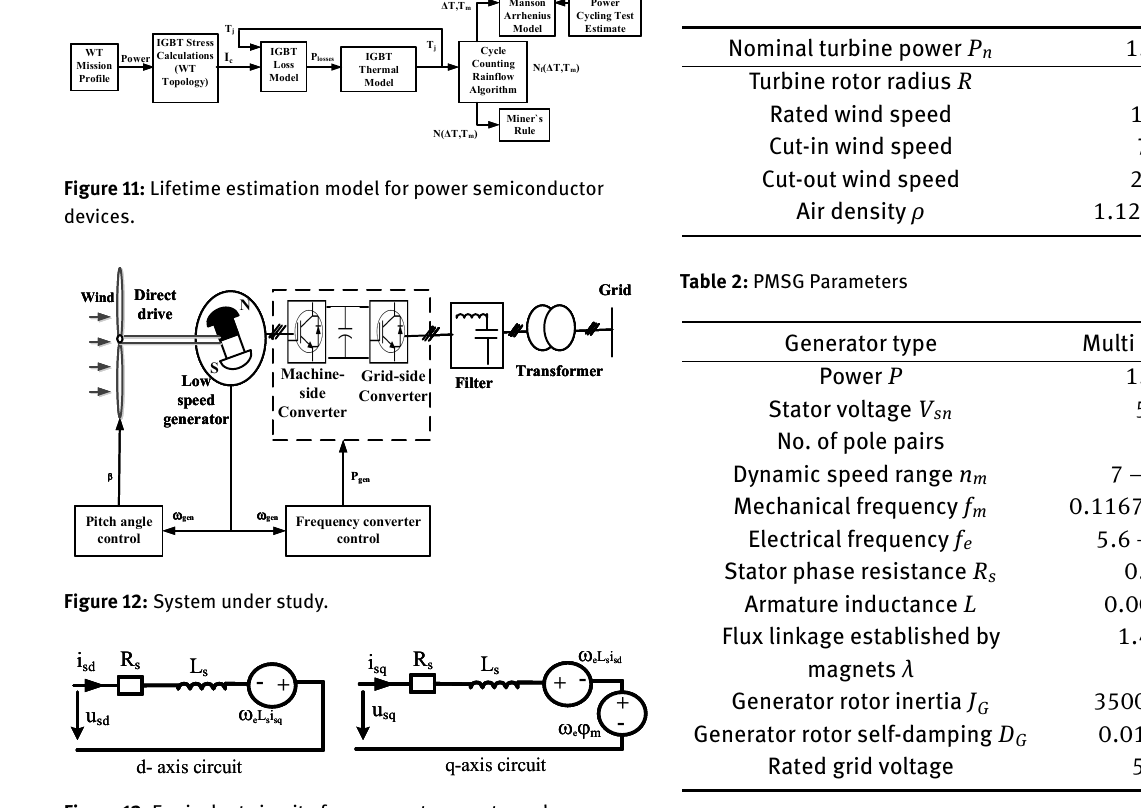
Figure 13: Equivalent circuit of permanent magnet synchronous generator